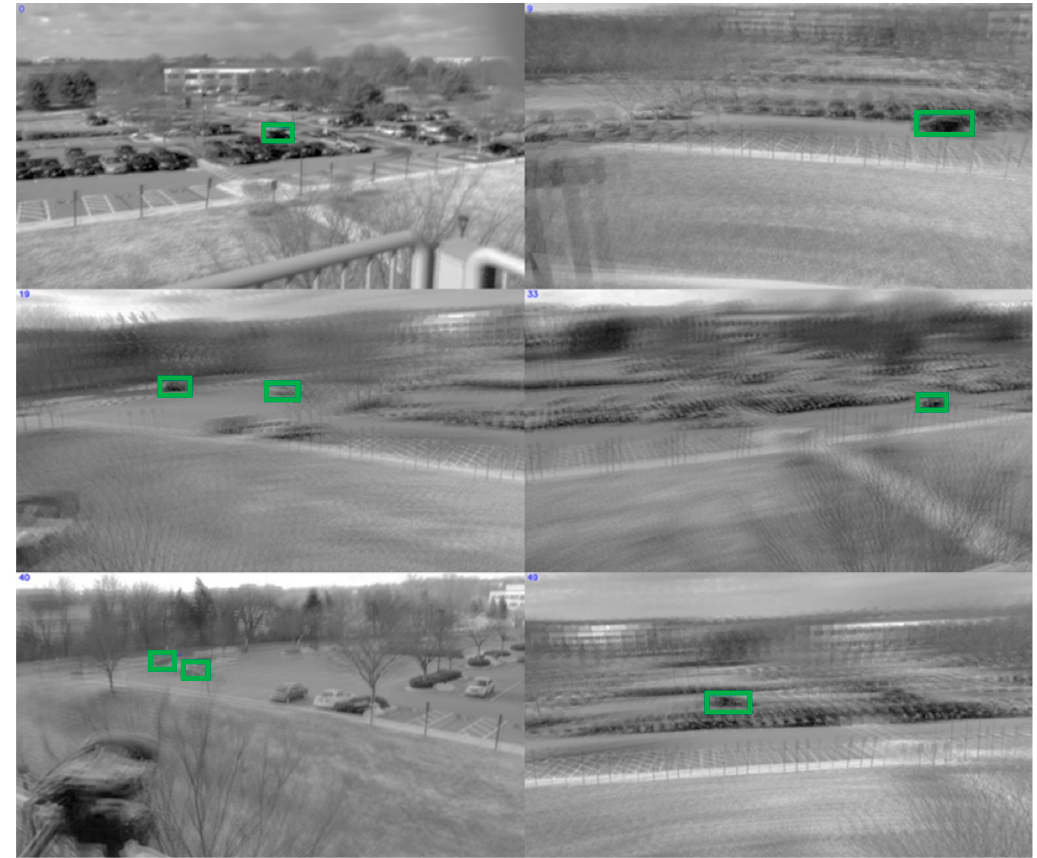
Table 4. Performance metrics for 0 and 50 percent missing pixels. JHU fire escape scenario: Video IMG430.